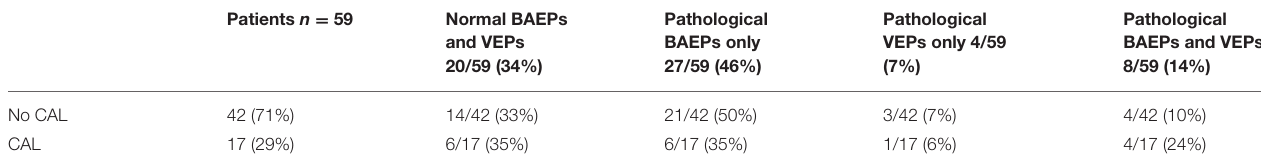
TABLE 3 | Pathological BAEPs and VEPs and CAL: distribution of the cases.